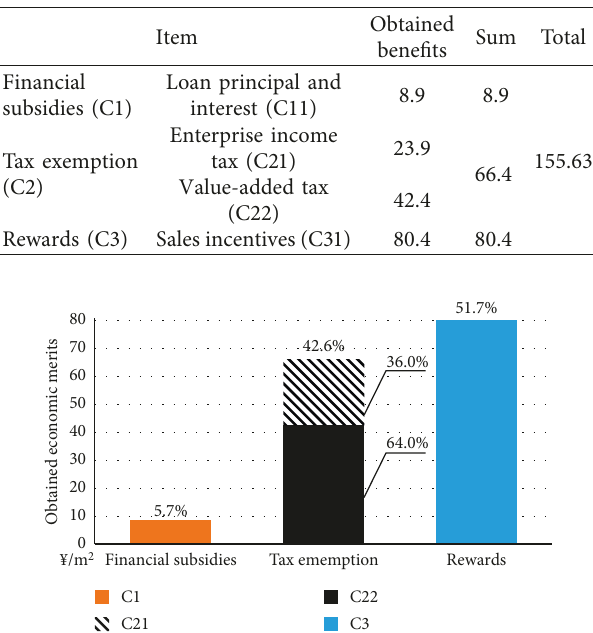
Figure 8: Economic proportions of indicators from time-saving perspective. Table 5: Results of economic merits by adopting incentive policies (¥/m 2 ).